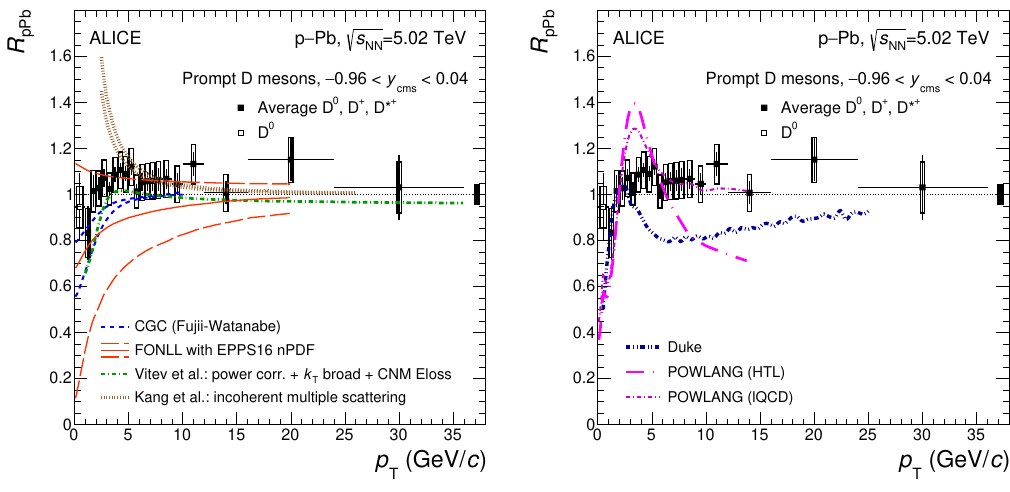
Figure 9 . Nuclear modi(cid:12)cation factor R pPb of prompt non-strange D mesons in p{Pb collisions at p s = 5 : 02 TeV. In the left panel, the data are compared with calculations of theoretical models NN that include only CNM e(cid:11)ects: CGC [82], FONLL [2] with EPPS16 nPDFs [14], a LO pQCD calculation (Vitev et al.) [85], and a calculation based on incoherent multiple scatterings (Kang et al.) [86]. In the right panel, the predictions of the Duke [52] and POWLANG [53] transport models are compared with the measured D-meson R pPb . The vertical bars and the empty boxes represent the statistical and systematic uncertainties. The black-(cid:12)lled box at R pPb = 1 represents the normalisation